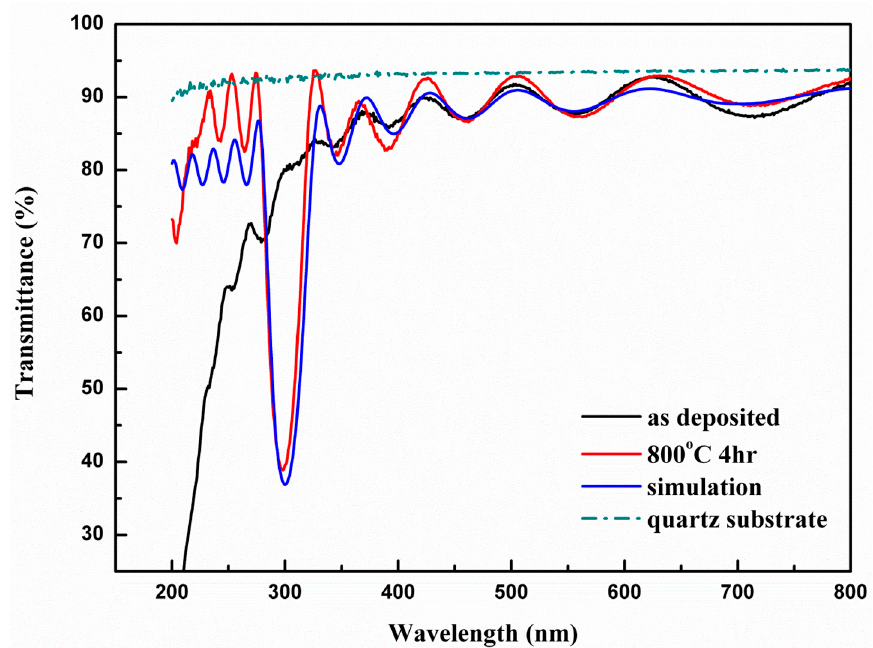
Figure 6. The transmittance spectra of thin films as deposited (black line), after annealing (red line), and according to simulation (blue line).